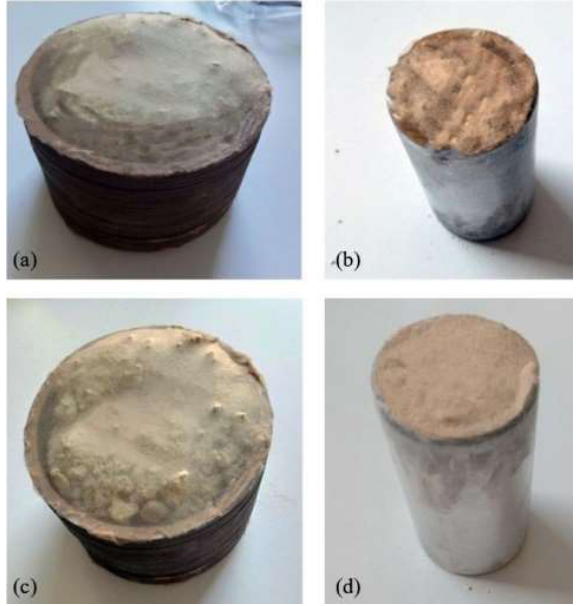
Figure 5. Göreme rock sample ( a ) for low-frequency setup; ( b ) for high-frequency setup; Ürgüp rock sample ( c ) for low-frequency setup; ( d ) for high-frequency setup.